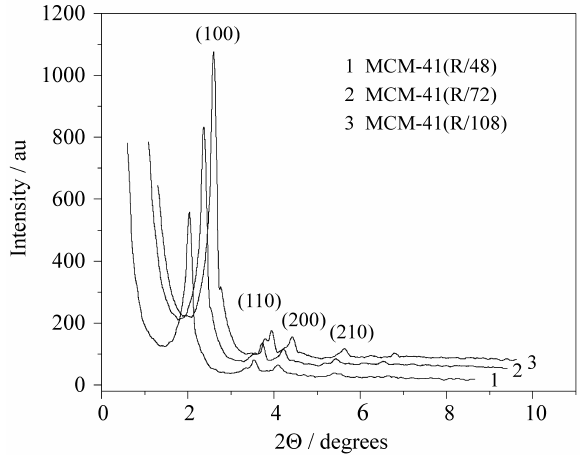
Figure 3. XRD of the as synthesized SiMCM-41(R/Y) samples.